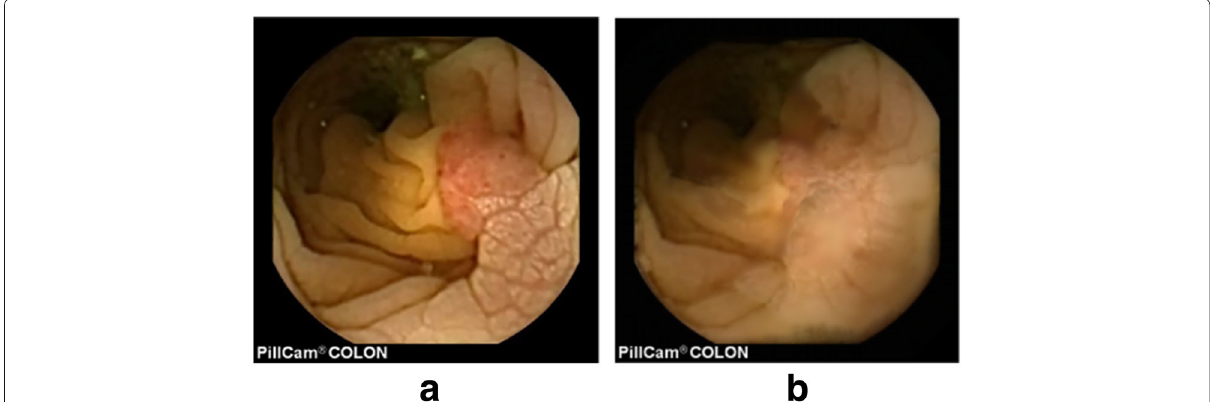
Fig. 4 Large displacement between neighboring frames with maximum magnitude of flow 92 pixels: frame interpolation for frame 7 of Seq2. a The ground truth frame. b Estimated based on frame 6 and 8. The polyp shown in a appears only in a single frame (frame number